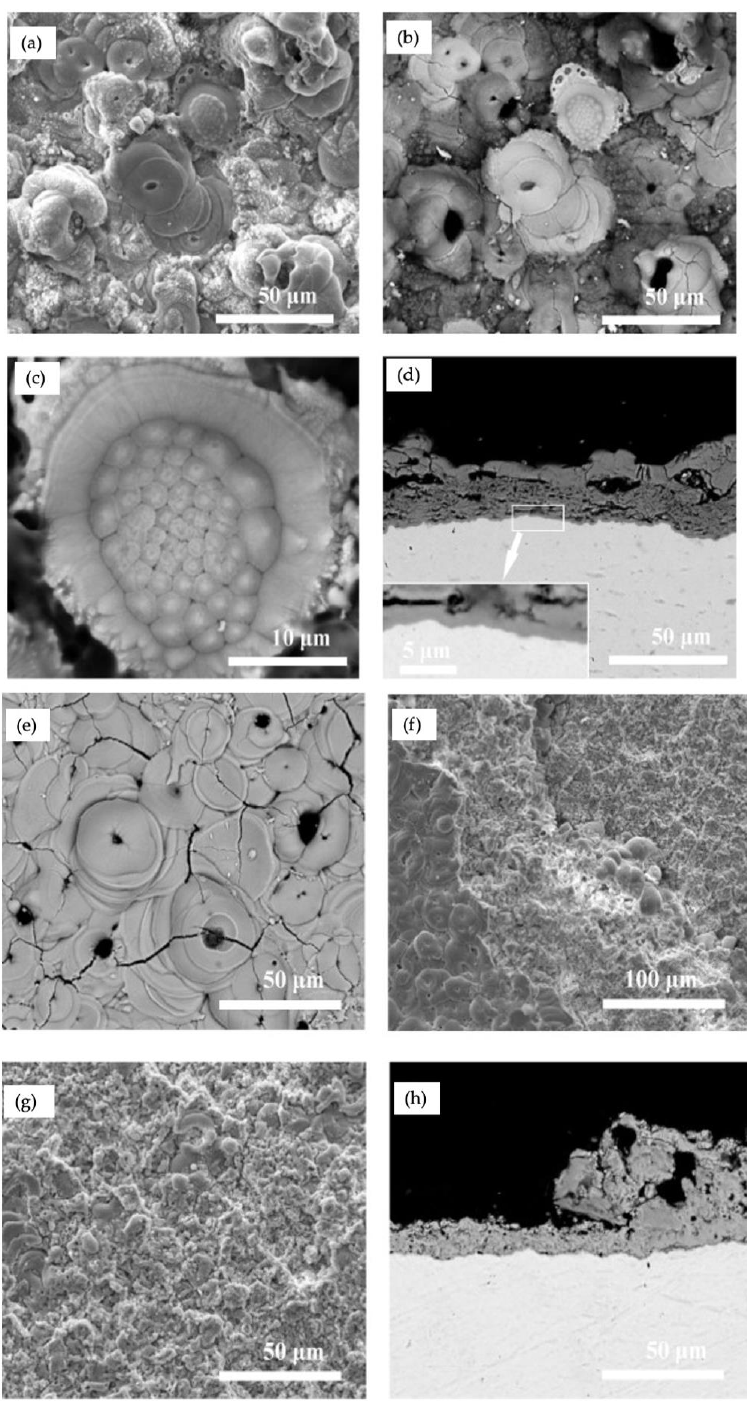
Figure 7. ( a – c ) Surface morphology, and ( d ) Cross-sectional image of the PEO coating formed for 1800 s in the silicate electrolyte; ( e – g ) Surface morphology, and ( h ) Cross-sectional image of a coating formed for 1800 s in the aluminate electrolyte [26] (reproduced with permission number: 5043480179625, Elsevier).